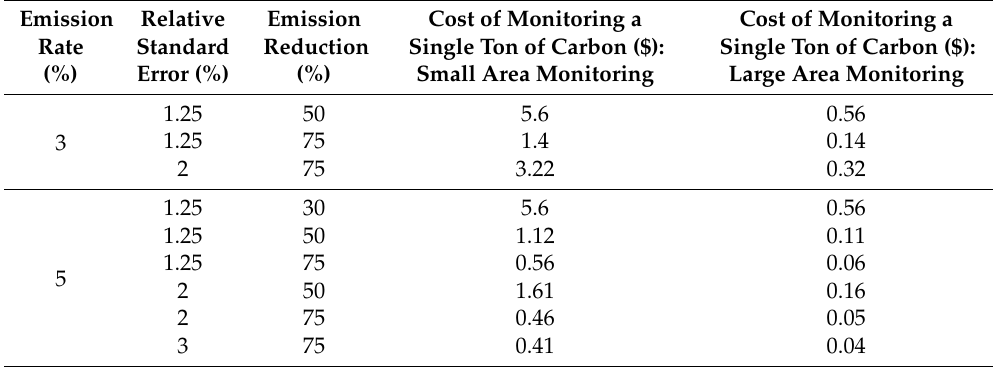
Table 4. Price paid for monitoring a single ton of carbon under different emission rates and monitoring